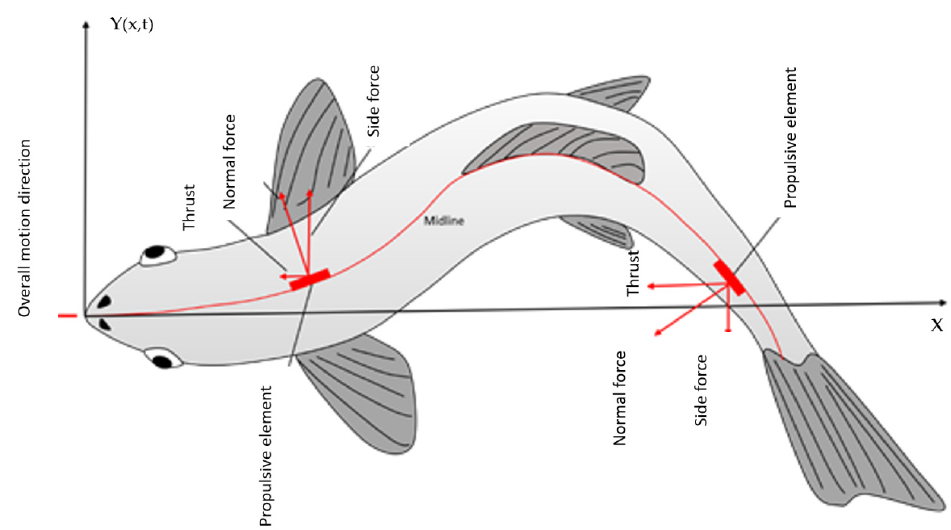
Figure 3. Reference coordinate system with the origin in the tip of the fish snout and the x axis directed along the midline of fish body when it is in straight configuration, positive towards the tail.